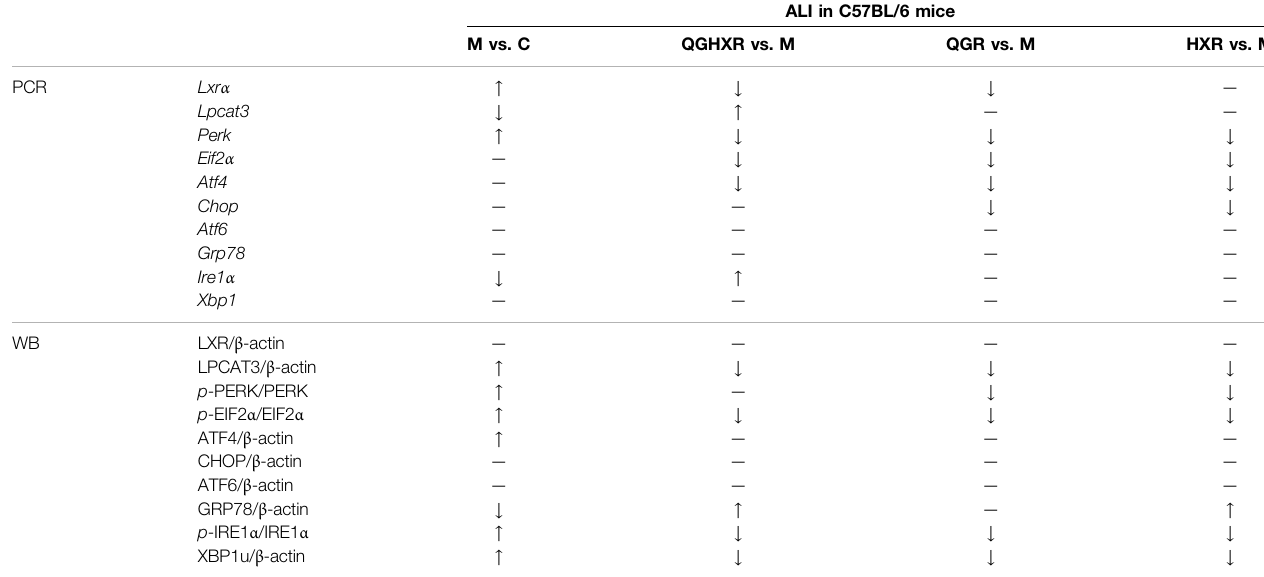
TABLE 1 | Protective effect of QGHXR against alcohol-induced liver injury in C57BL/6 mice through the LXR α -LPCAT3-ERS pathway.